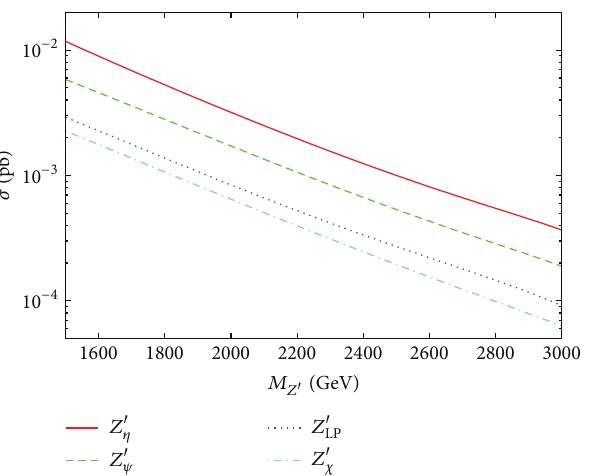
Figure 11: The cross sections for 𝑝𝑝 → (𝑡 󸀠 𝑡 + 𝑡 󸀠 𝑡) + 𝑋 versus the 𝑍 󸀠 boson mass at the LHC with √𝑠 = 13 TeV. The lines are for the four 𝑍 󸀠 models as explained in the text and the values of parameters | = 2 (where 𝑖 runs from 1 to 3) are used. The mass value of |𝐴 𝑖4 = 700 GeV and the FCNC parameter is used 𝑡 󸀠 quark is used as 𝑚 𝑡 󸀠 as 𝑥 = 0.1 .